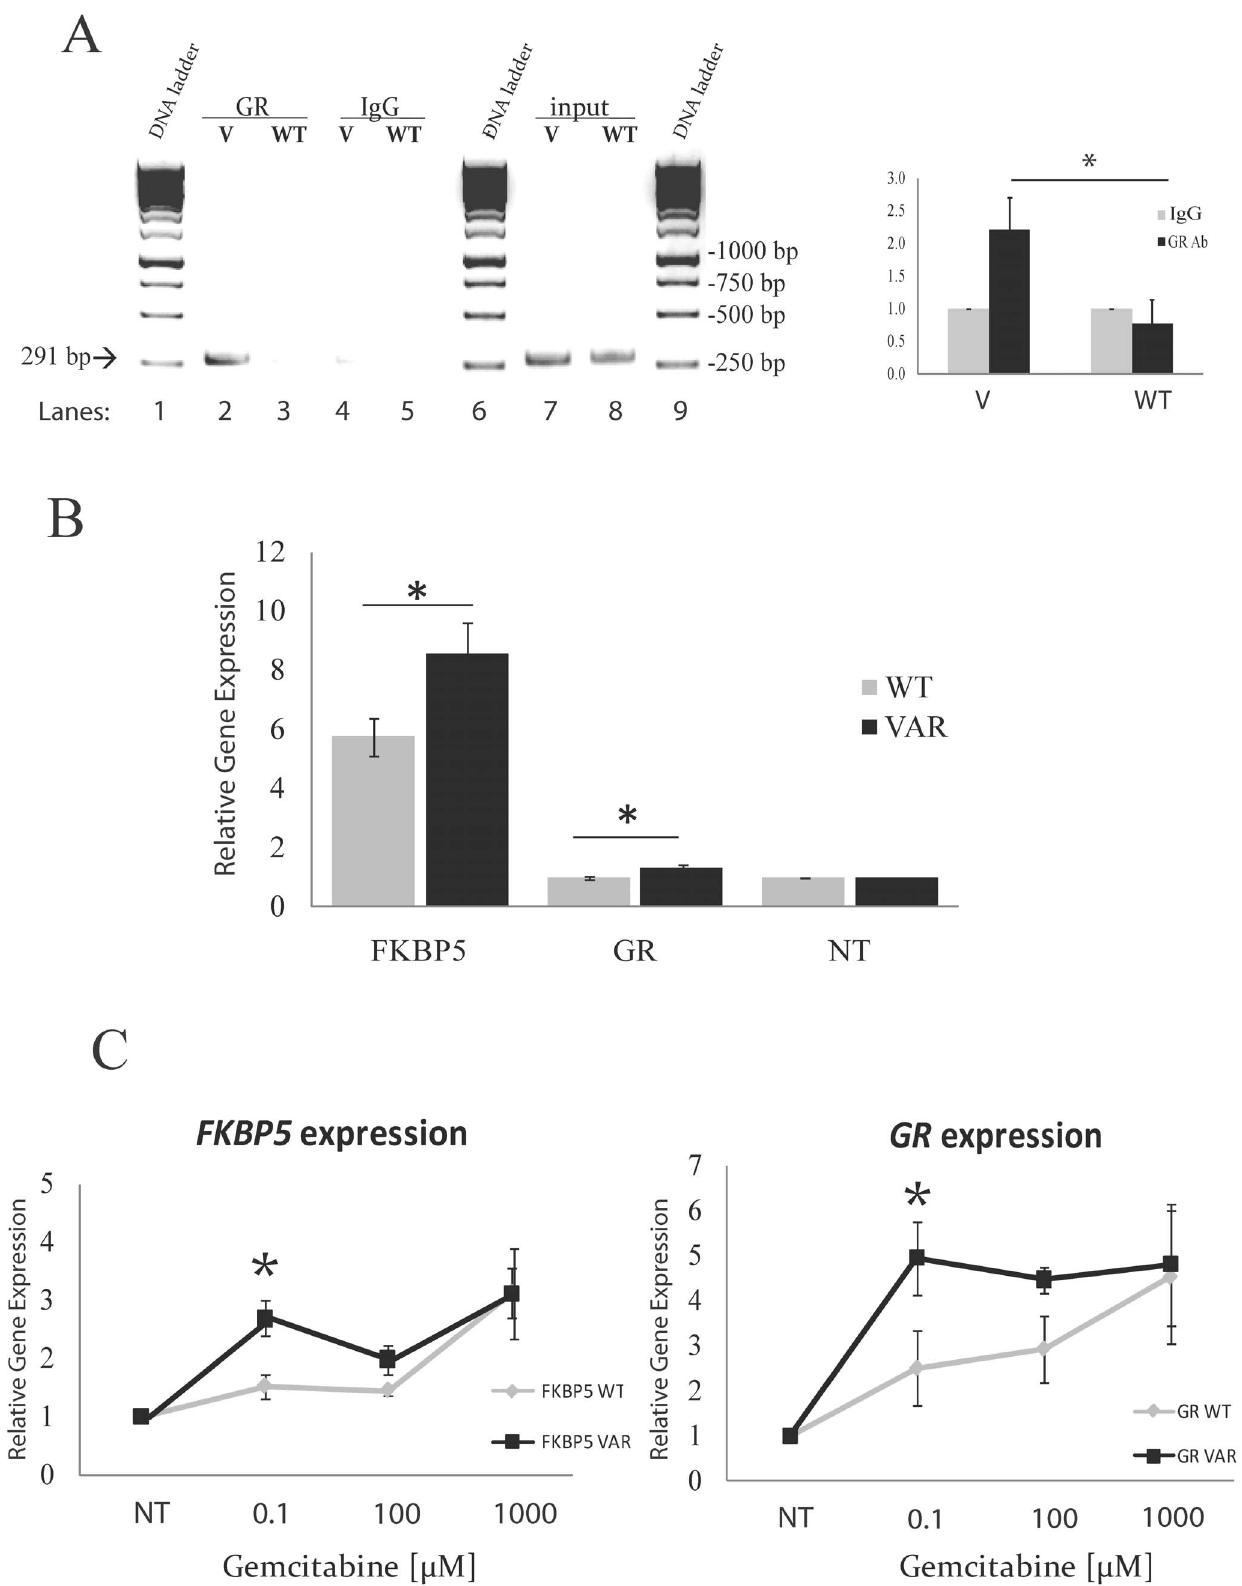
Figure 3. Functional characterization of the rs73748206 using pancreatic cancer patients’ lymphoblastoid cell lines (LCLs). (A) ChIP assay using lymphoblastoid cells with known genotype for the rs73748206 single nucleotide polymorphism (SNP). Left panel indicates a picture of gel electrophoresis. Lanes 1, 6, 9 correspond to DNA ladders. Lanes 2 to 5 are polymerase chain reaction (PCR) products from DNA that was bound to